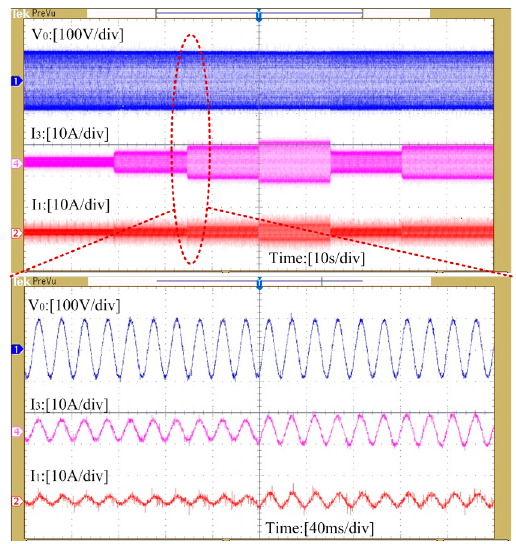
Figure 14. Experimental voltage and current waveforms.